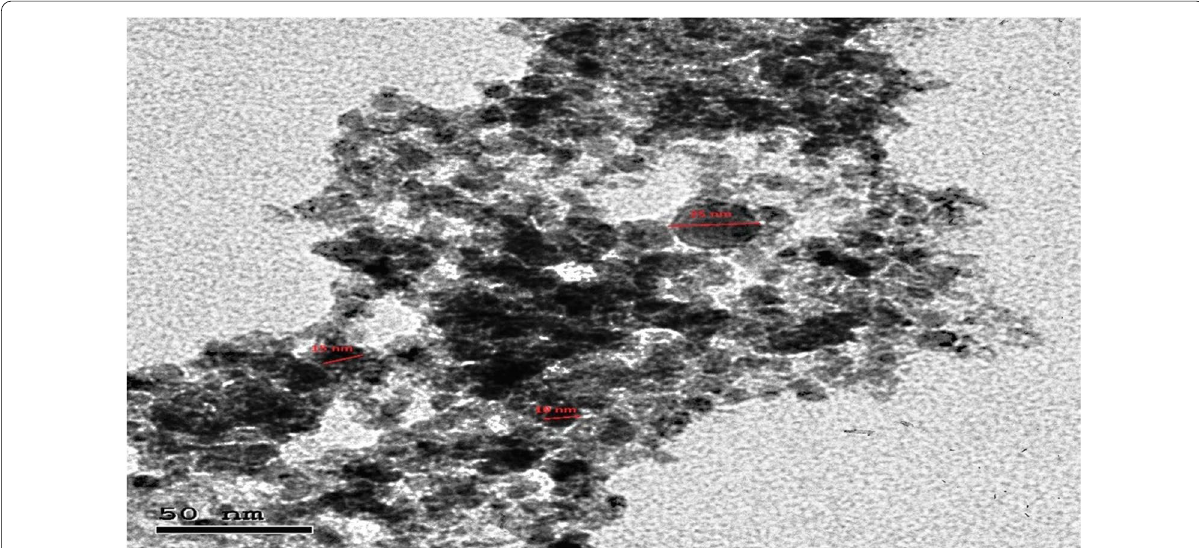
Fig. 2 TEM image conforming the nano‑size of Fe 3 O 4 NPs with size about 35 nm and spherical shape with aggregate less